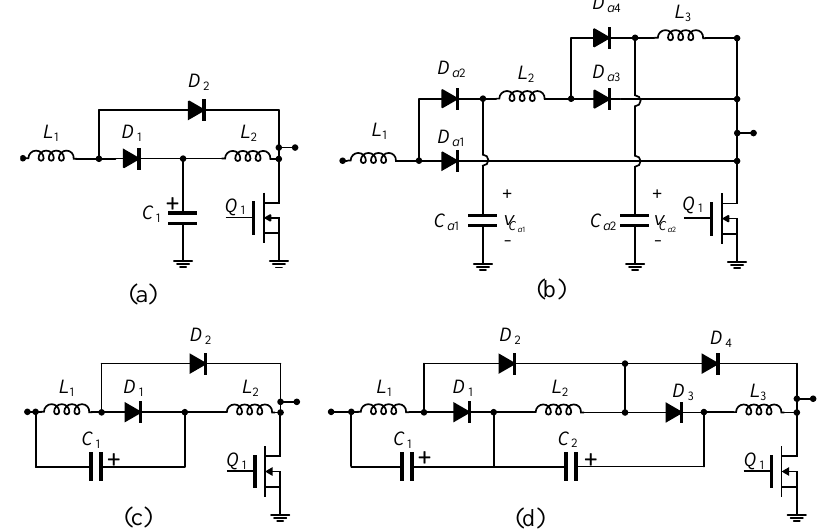
Figure 2. Multistage boost converters ( a ) Quadratic cell with a grounded capacitor, ( b ) Cubic cell with grounded capacitors, ( c ) Quadratic cell with a floating capacitor, and ( d ) Cubic cell with floating